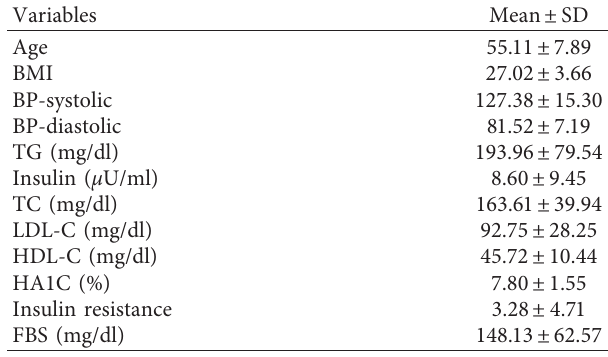
Table 1: Demographic and clinical characteristics of participants ( n �